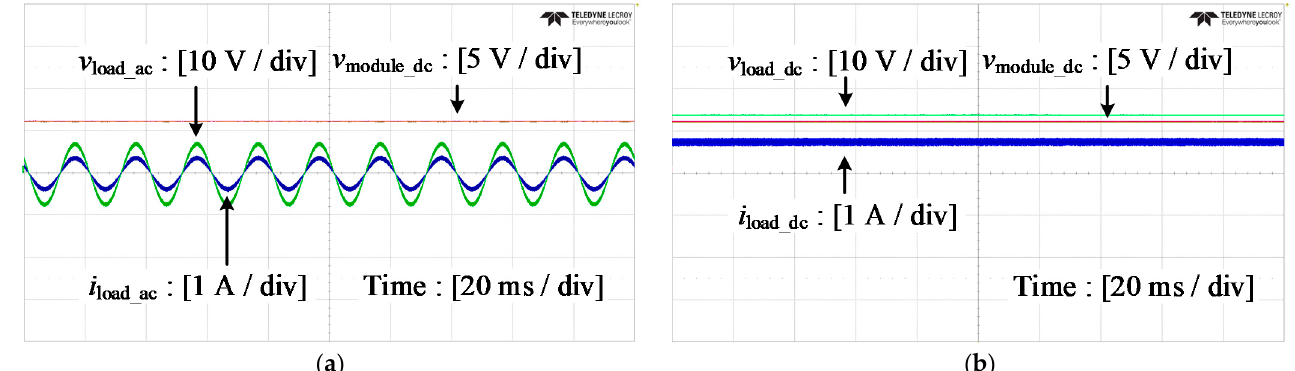
Figure 19. Experimental results of the lattice converter with multiple outputs: ( a ) ac output port; ( b ) dc output port.